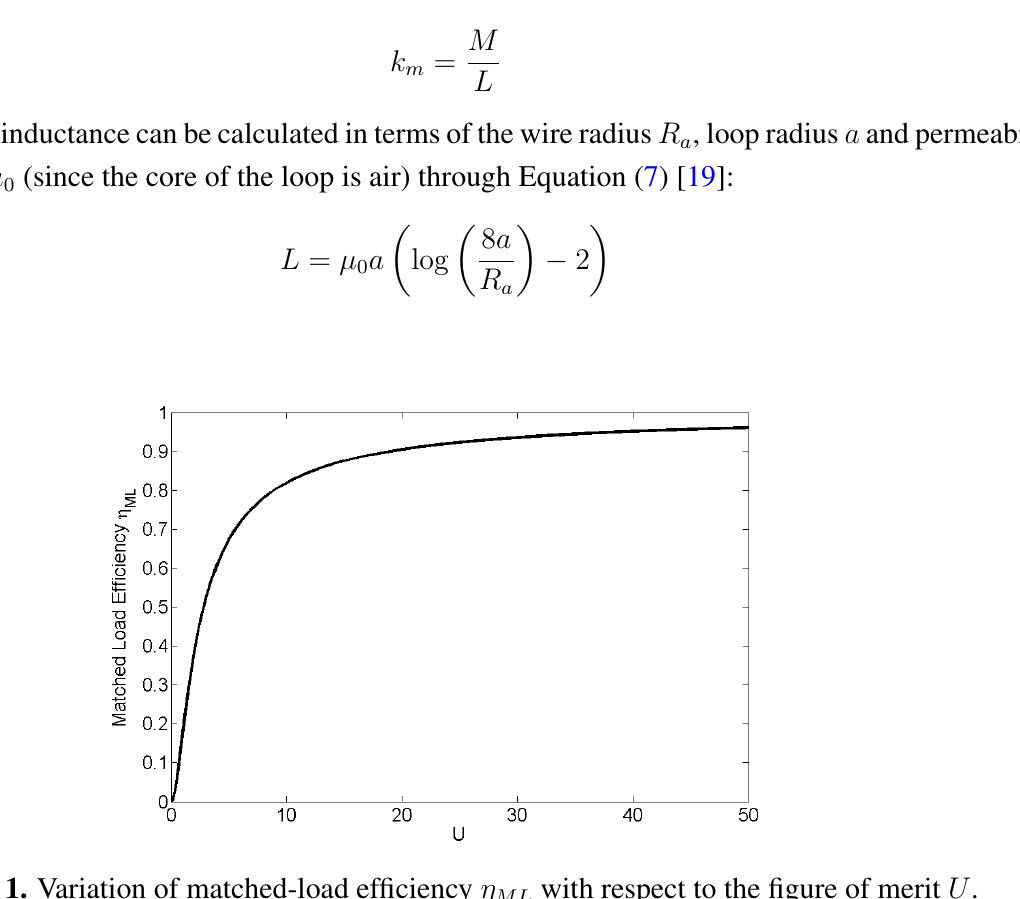
with respect to the figure of merit U . ML